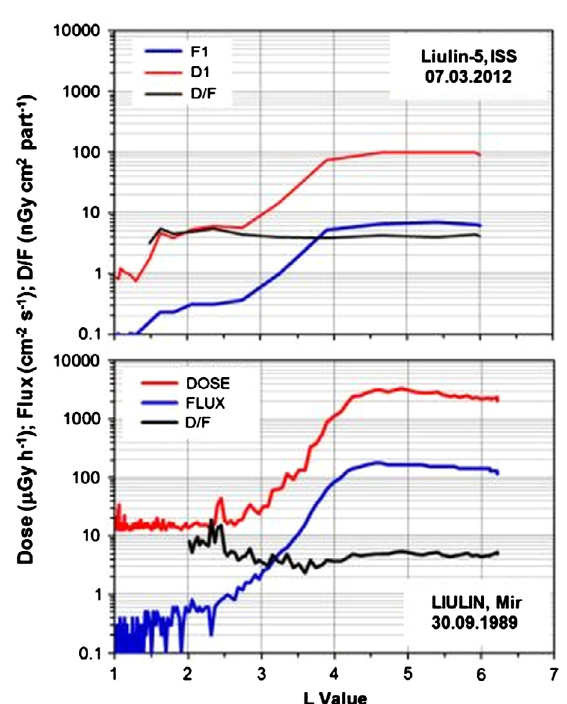
Fig. 8. Flux (blue curves) absorbed dose rate (red curves) and ratio absorbed dose/flux (black curves) versus L value. Upper plot displays the data by the D1 detector of Liulin-5 on the ISS during the SEP event on 07 March 2012 from 17:20:08 UT to 17:46:30 UT. The bottom plot displays the same parameters obtained by the Liulin dosimeter on the Mir space station during the SEP event on 30 September 1989 from 00:54:10 UT to 01:18:40 UT. The data in both plots are taken outside the